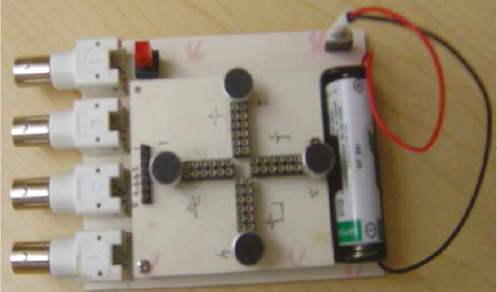
Figure 15: Four microphones measure interaural time di ff erences of an object, and the azimuth and elevation angles are derived by scaling the speed of wave propagation and the unit dimensions of the microphones